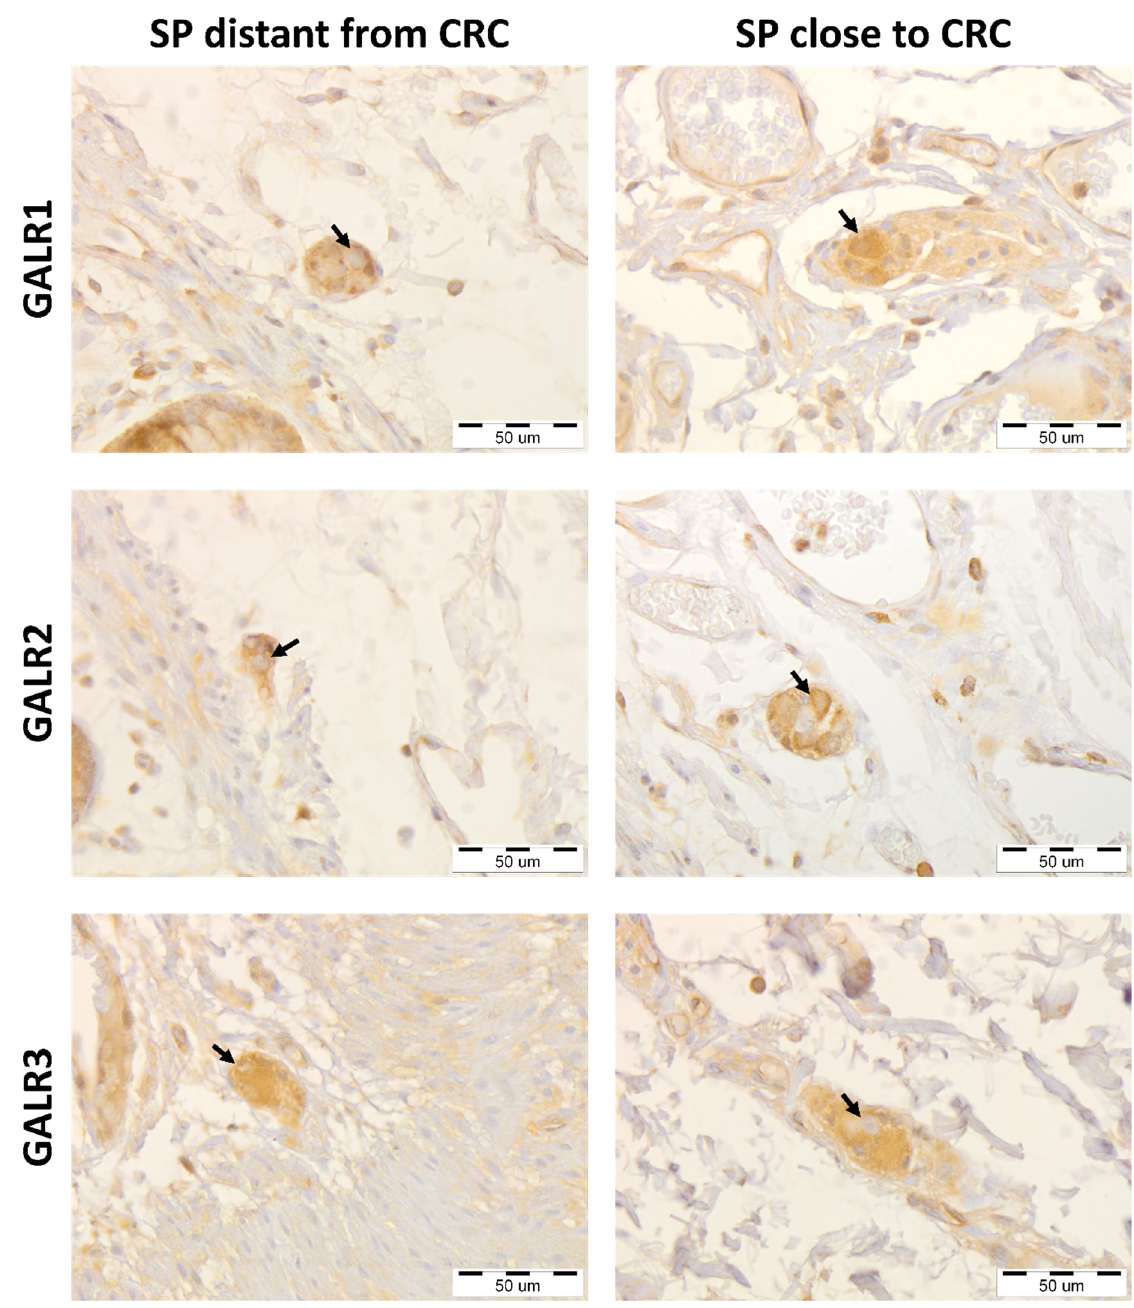
Figure 5. Immunohistochemical expression of galanin receptors (GALR1, GALR2, and GALR3) in submucosal plexuses (SP) distantly located from the colorectal cancer (CRC) tissue compared with their expression in the submucosal plexuses in the vicinity of cancer invasion of the same, representative CRC patients (n = 32). Neurons expressing respective GALRs are marked by arrows. Total magnification: 400×.